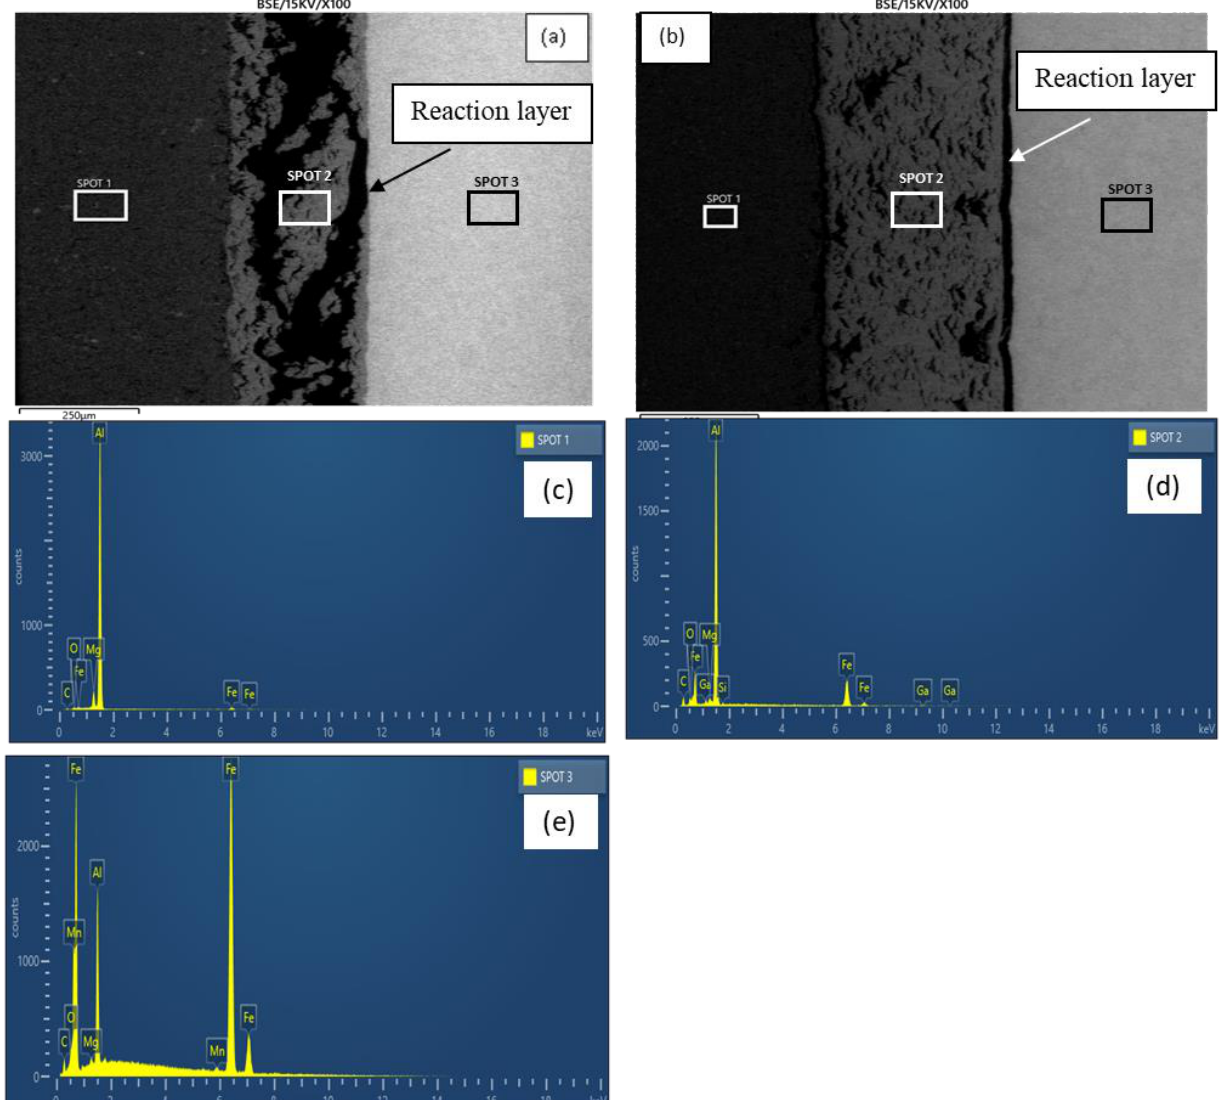
Figure 7. ( a ) Micrograph of sample E; ( b ) Micrograph of sample F; ( c ) Sample F EDX analysis (spot 1); ( d ) Sample F EDX analysis (spot 2); ( e ) Sample F EDX analysis (spot 3).